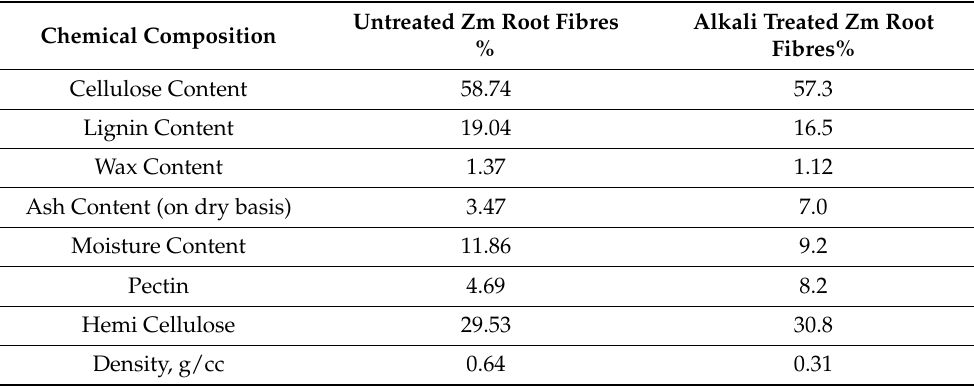
Table 9. Chemical Analysis of Zm